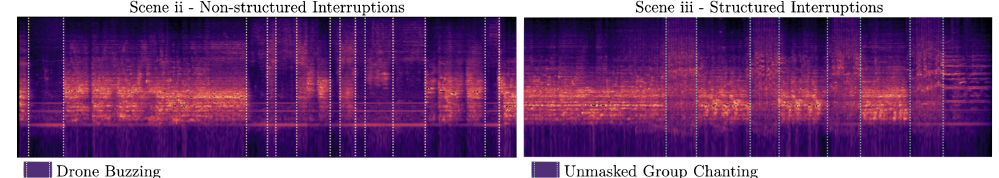
Figure 6. Spectrogram recording from two scenes, ii and iii , marked with interruptions of the granular